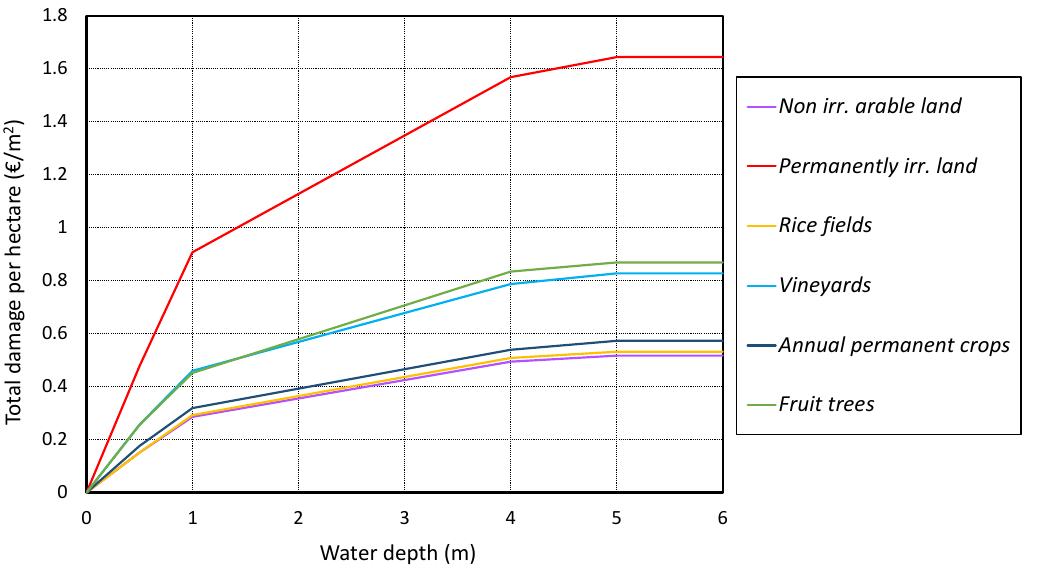
Figure 13. MLFP-2D model implementation: ( a ) layout of the model domain, including 2-m resolution DTM and the domain boundary (black dotted line); ( b ) inundated area for a single random generated hydrograph and a given initial water level reservoir condition (IWL1).